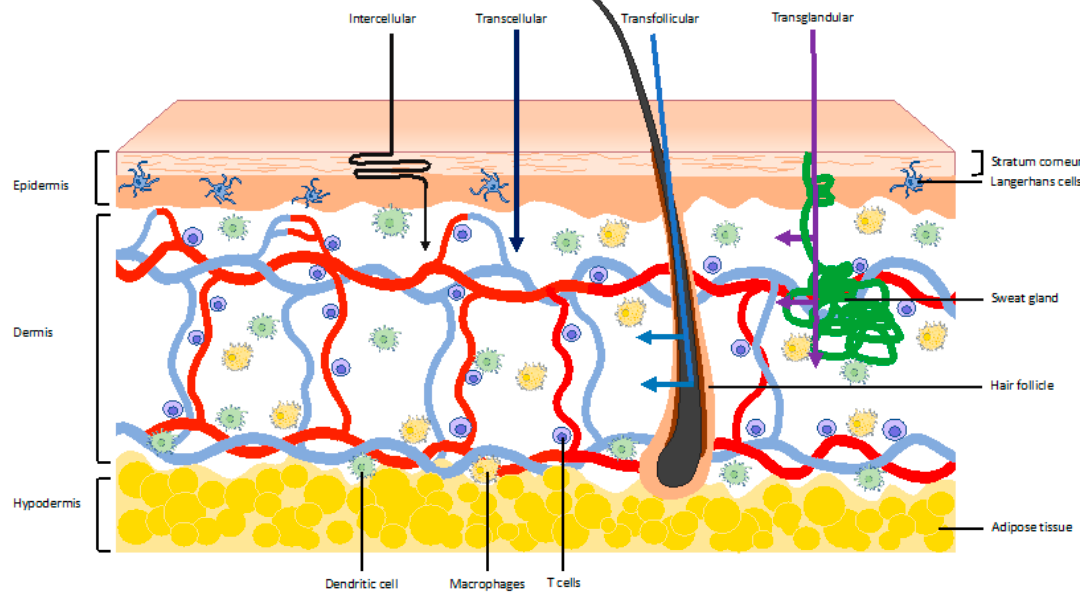
Figure 1. Schematic representation of the skin, the distribution of a variety of immune cells, and potential routes to bypass the stratum